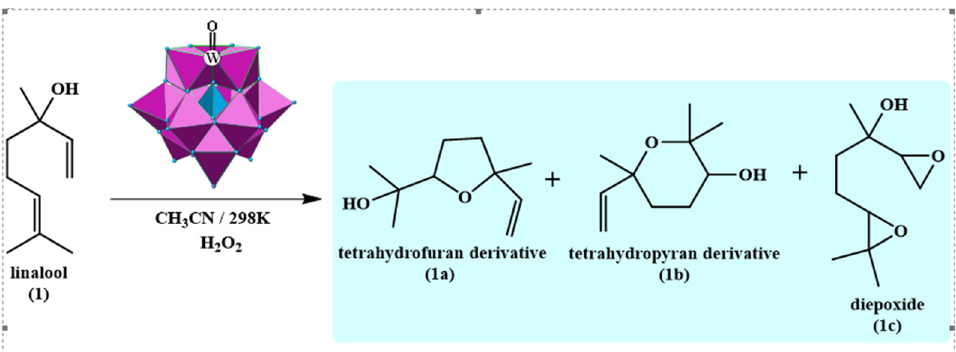
Scheme 13. Main products of Na 7 PW 11 O 39 -catalyzed linalool oxidation with hydrogen peroxide (adapted from ref. [30]).